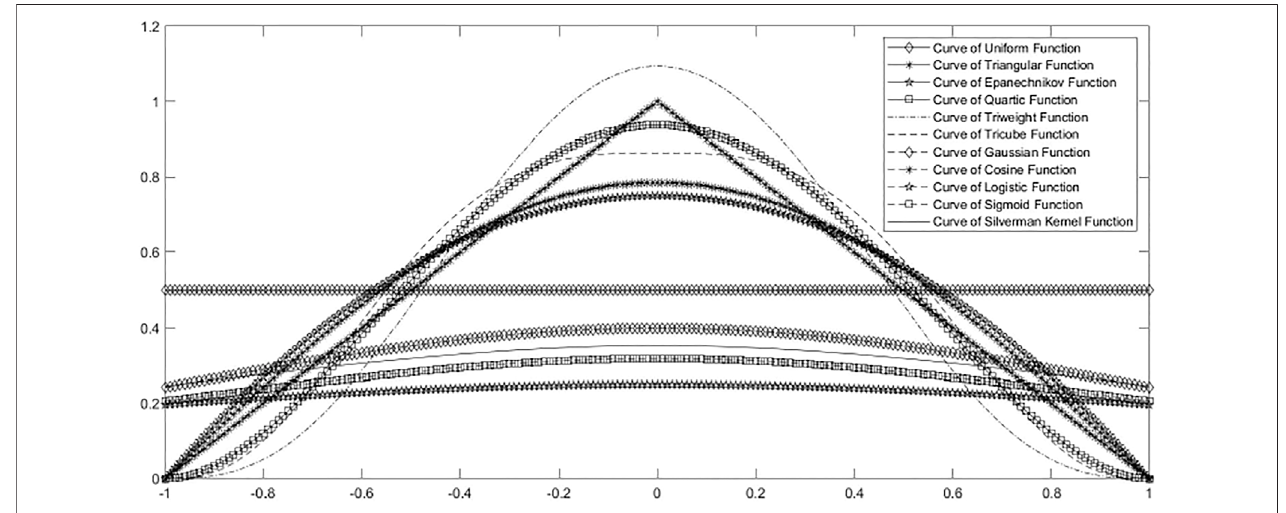
FIGURE 3 | Probability density of various kernel